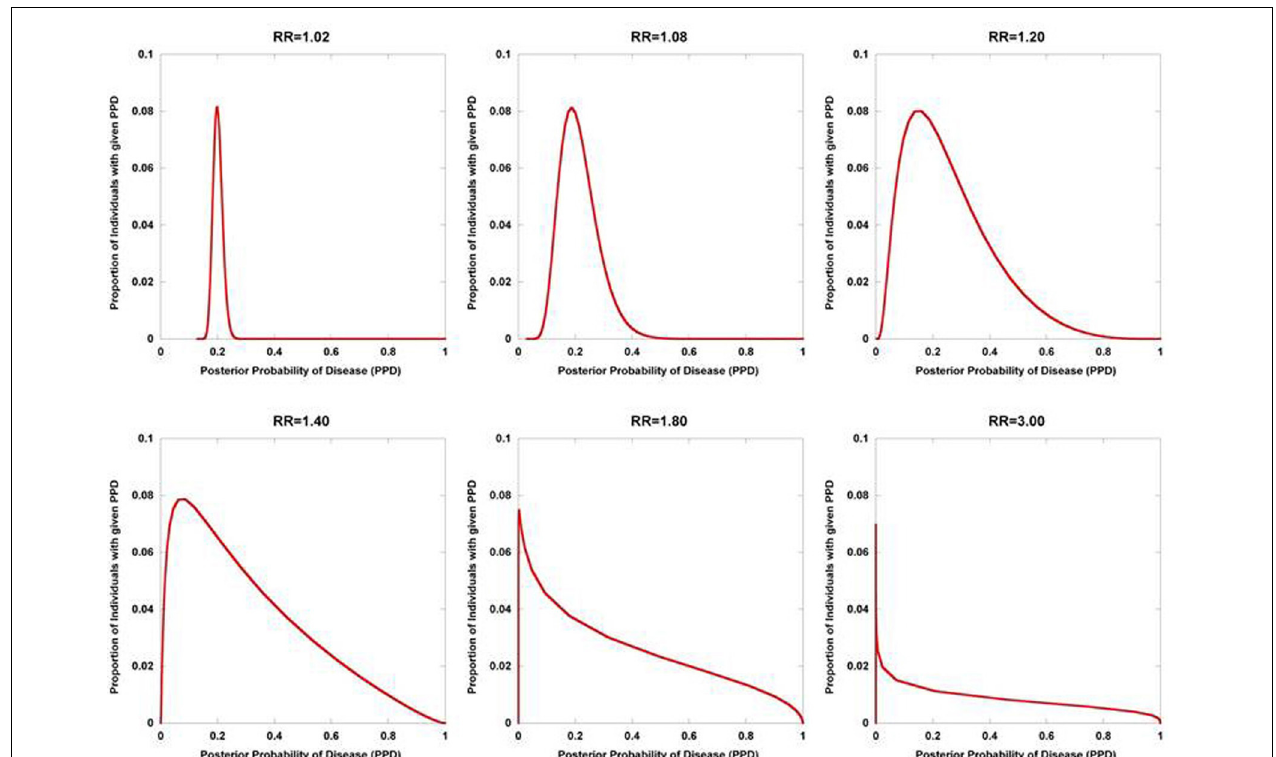
FIGURE 2 | Posterior probability variation with relative risk. The density of posterior probabilities of disease (PPD) are shown under a simplified multilocus disease model. The number of independent, disease-predisposing SNPs was set at 500. Relative risk was modeled as being identical for each predisposing SNP. Frequency of the predisposing genotype in controls was set to 0.05 at each SNP. Prior probability of